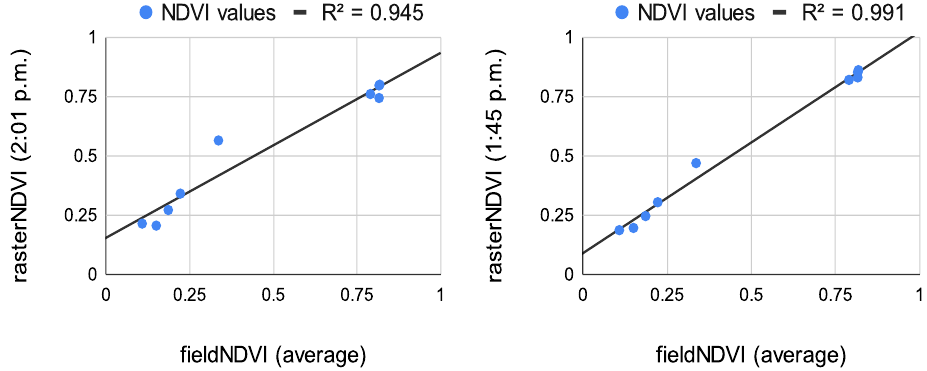
Figure 8. Correlation between the average NDVI values for the sample NDVI points and raster NDVI values from Sequoia ( left ) and multiSPEC 4c ( right ).